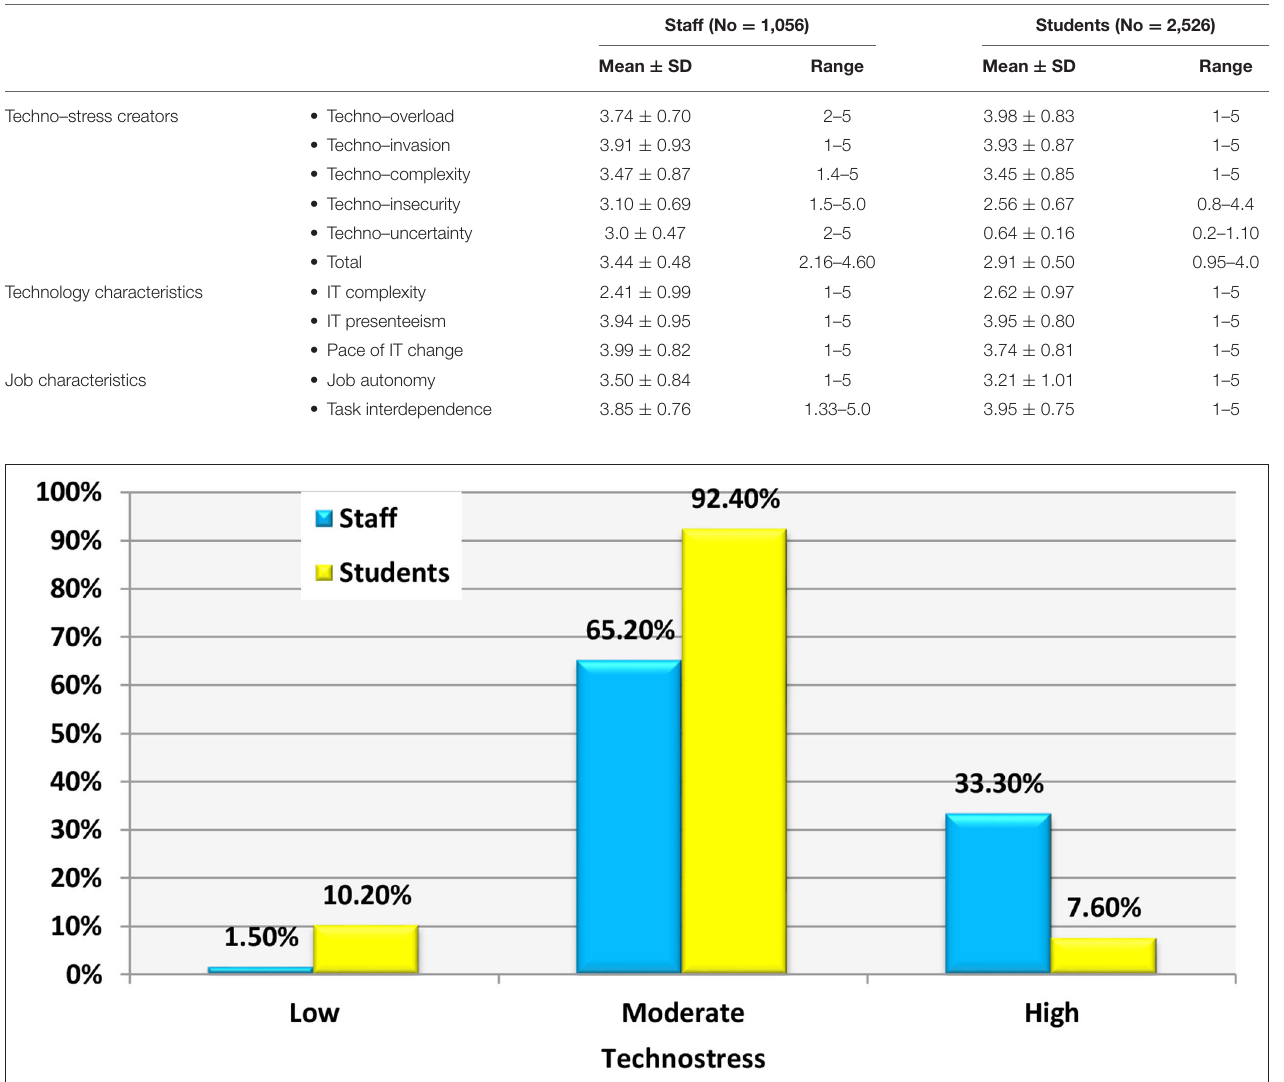
FIGURE 2 | Distribution of the studied groups regarding the prevalence of